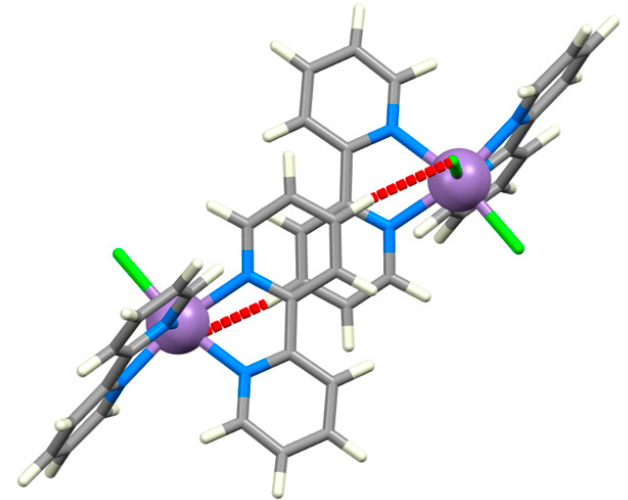
Figure 9. Centrosymmetric packing motif in [Mn(bpy) 2 Cl 2 ] · SC(NH 2 ) 2 (CSD refcode ADE- The H4...Cl contacts are shown in red (CH4...Cl = 2.591 Å, C...Cl = 3.649(7) Å, angle C–H4...Cl = 163.5°).